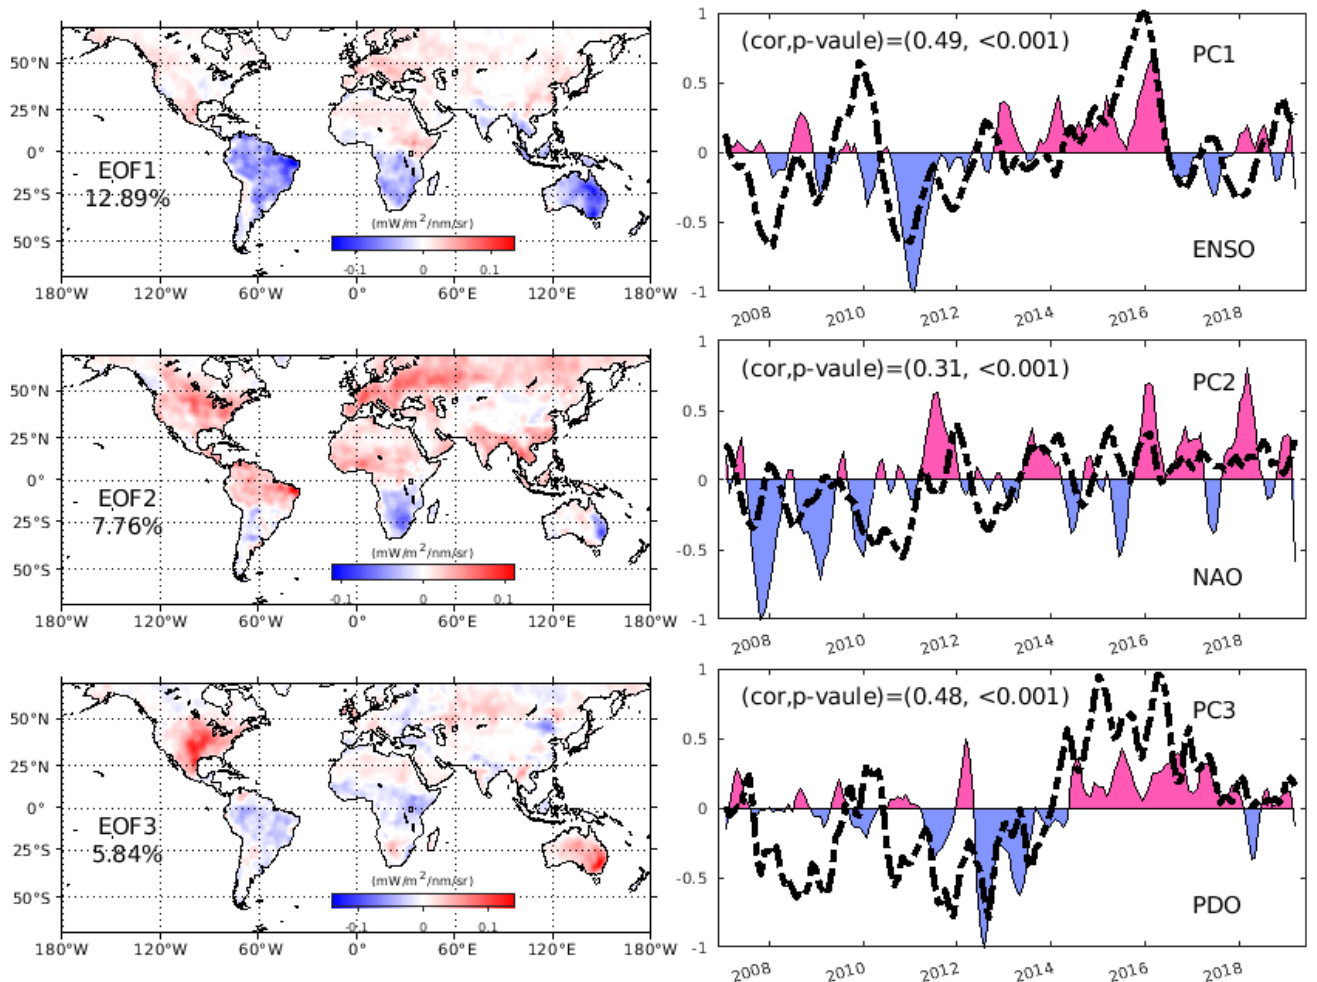
Figure 2. (left ) Global rotated EOF spatial patterns of the first three SIF modes calculated for the 2007–2019 period. ( right ) Monthly time series (color-shaded, 2007–2019) of the principal components (PCs) associated with the first three global rotated EOF modes. Monthly time series (dashed lines) of correlated climate indices (ENSO for PC1, NAO for PC2, and PDO for PC3) are normalized and superimposed. No time-lag or running mean are performed on these time series. The Pearson correlation coefficient and p-value are given for each time series pair.